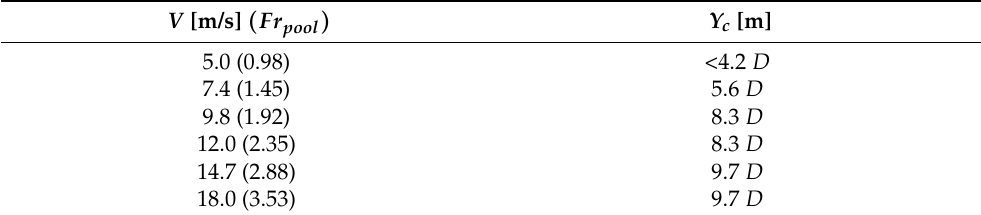
Table 3. Core persistence (or core length) Y c depending on jet velocity V